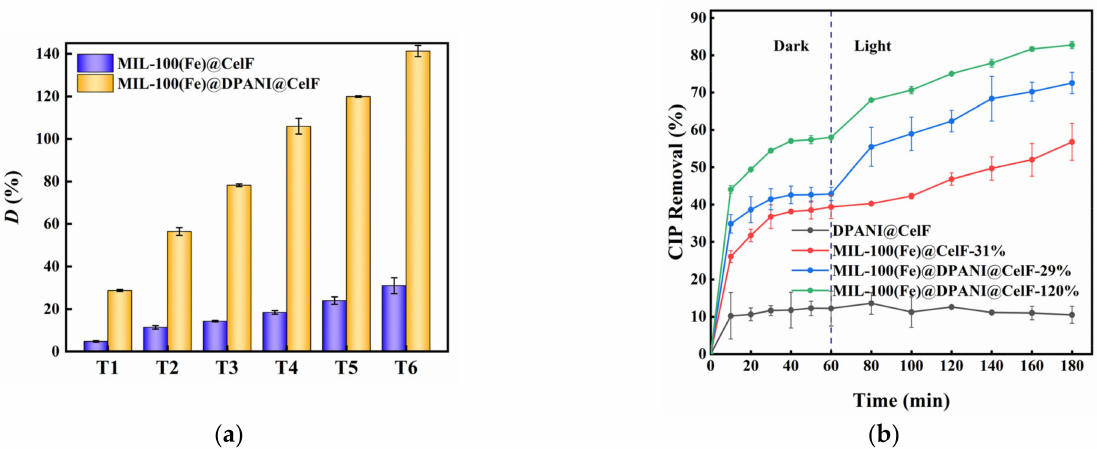
Figure 5. ( a ) Comparison of MIL-100(Fe) deposition on CelF and DPANI@CelF; ( b ) comparison of CIP removal by CelF composites via adsorption-photocatalysis (28%, 31% and 120% refer to the deposition ratios of MIL-100(Fe), 0–60 min for adsorption and 60–180 min for